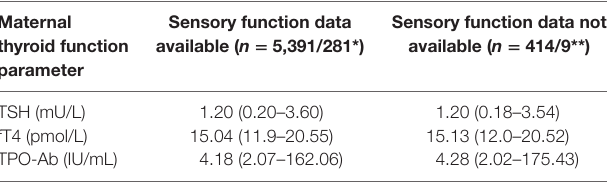
TaBle 2 | Maternal thyroid function values, grouped by children with and without parent-reported questionnaire data. Maternal thyroid function